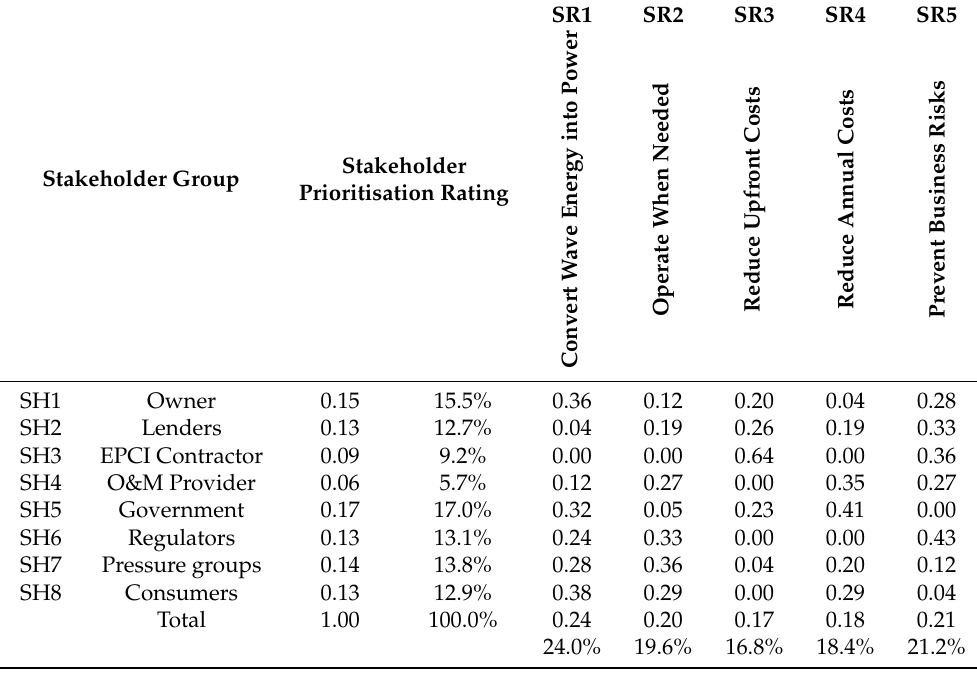
Table A4. Stakeholders (SH) to Stakeholder Requirements (SR) for Remote community generation.